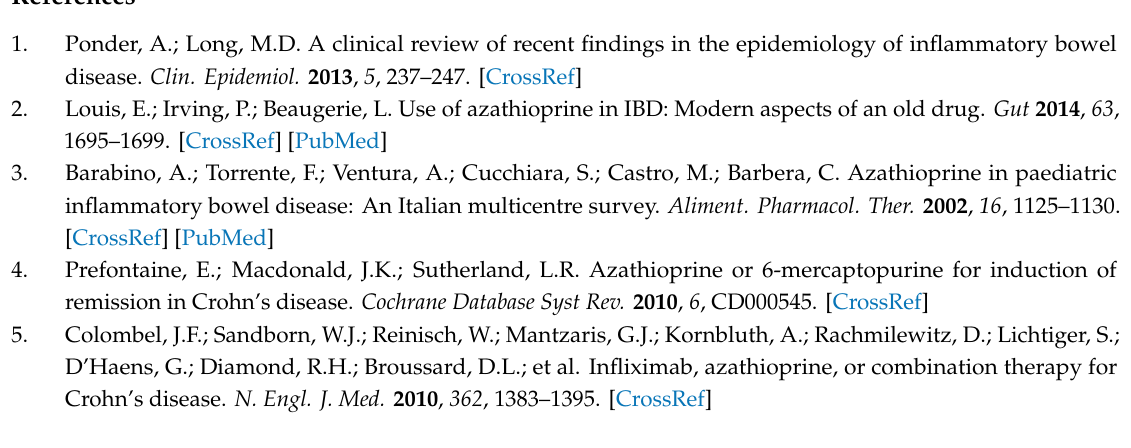
Figure S1: inflammatory bowel disease (IBD type) and azathioprine thioguanine nucleotide (TGN) metabolites, Figure S2: Patient’s age and azathioprine daily dose, Figure S3: Patient’s age and ratio between concentration of azathioprine thioguanine-nucleotide metabolites and azathioprine daily